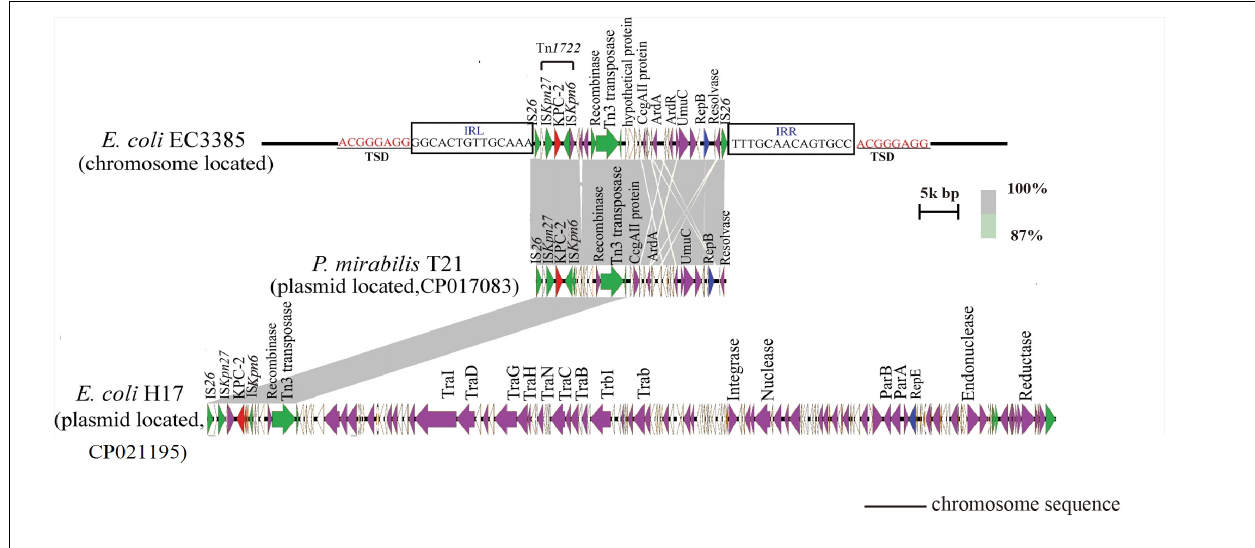
FIGURE 2 | Linear comparison of the 24-kb insertion sequence with closely related plasmids. The gray regions between plasmids indicate nucleotide identity (87–100%) determined by BLASTn. Arrows indicate predicted open reading frames (ORFs). The primary structural characteristics of the 24-kb insertion sequence are compared to plasmids pT21 (CP017083) and pH17 (CP021195). Colored arrows represent ORFs, with red, purple, yellow, green, and white representing antibiotic resistance genes; replication, recombination and repair genes; plasmid stability genes; mobile elements and plasmid transfer related-genes; and genes with unknown function genes,